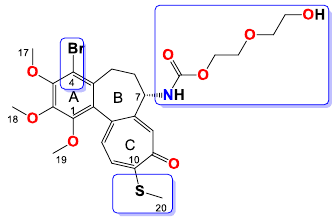
Figure 12. Structure of compound 12 .